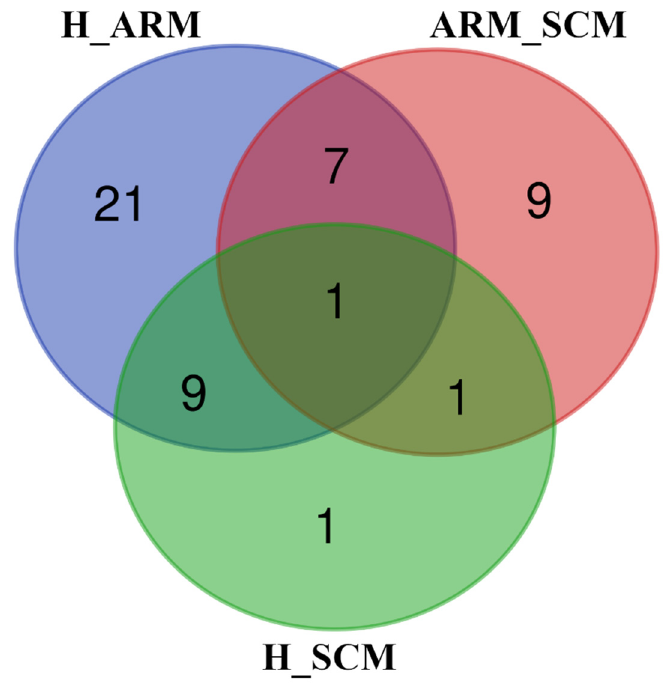
Figure 2. Venn diagram showing the number of unique or shared differentially expressed miRNAs in milk exosomes sampled from healthy (H) cows, cows with subclinical mastitis (SCM), and cows at risk of mastitis (ARM). H_ARM, H_SCM, and ARM_SCM refer to the pairwise comparisons between groups (Supplementary Table S1). Venn diagram was created by a web tool available at http://bioinformatics.psb.ugent.be/webtools/Venn/, accessed on 14 December 2022.